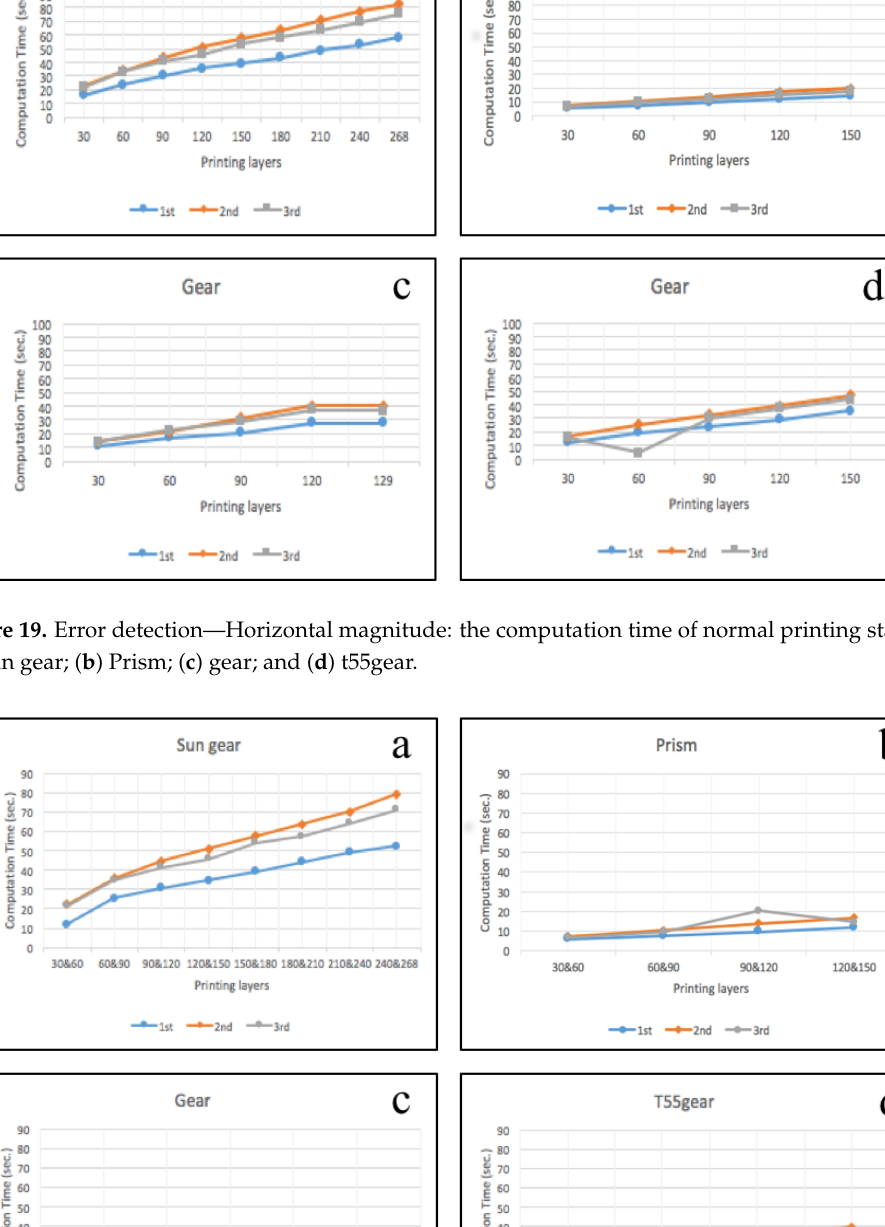
Figure 20. Error detection—Horizontal and vertical magnitude: the computation time of failure state for ( a ) sun gear; ( b ) Prism; ( c ) gear; and ( d ) t55gear.